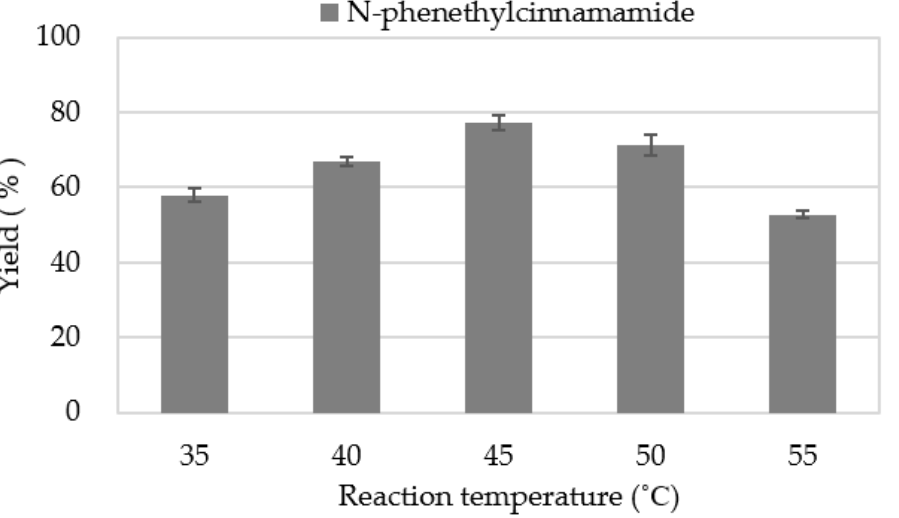
Figure 2. The effect of reaction temperature on the synthesis of N-phenethylcinnamamide catalyzed by Lipozyme ® TL IM in continuous-flow microreactors.